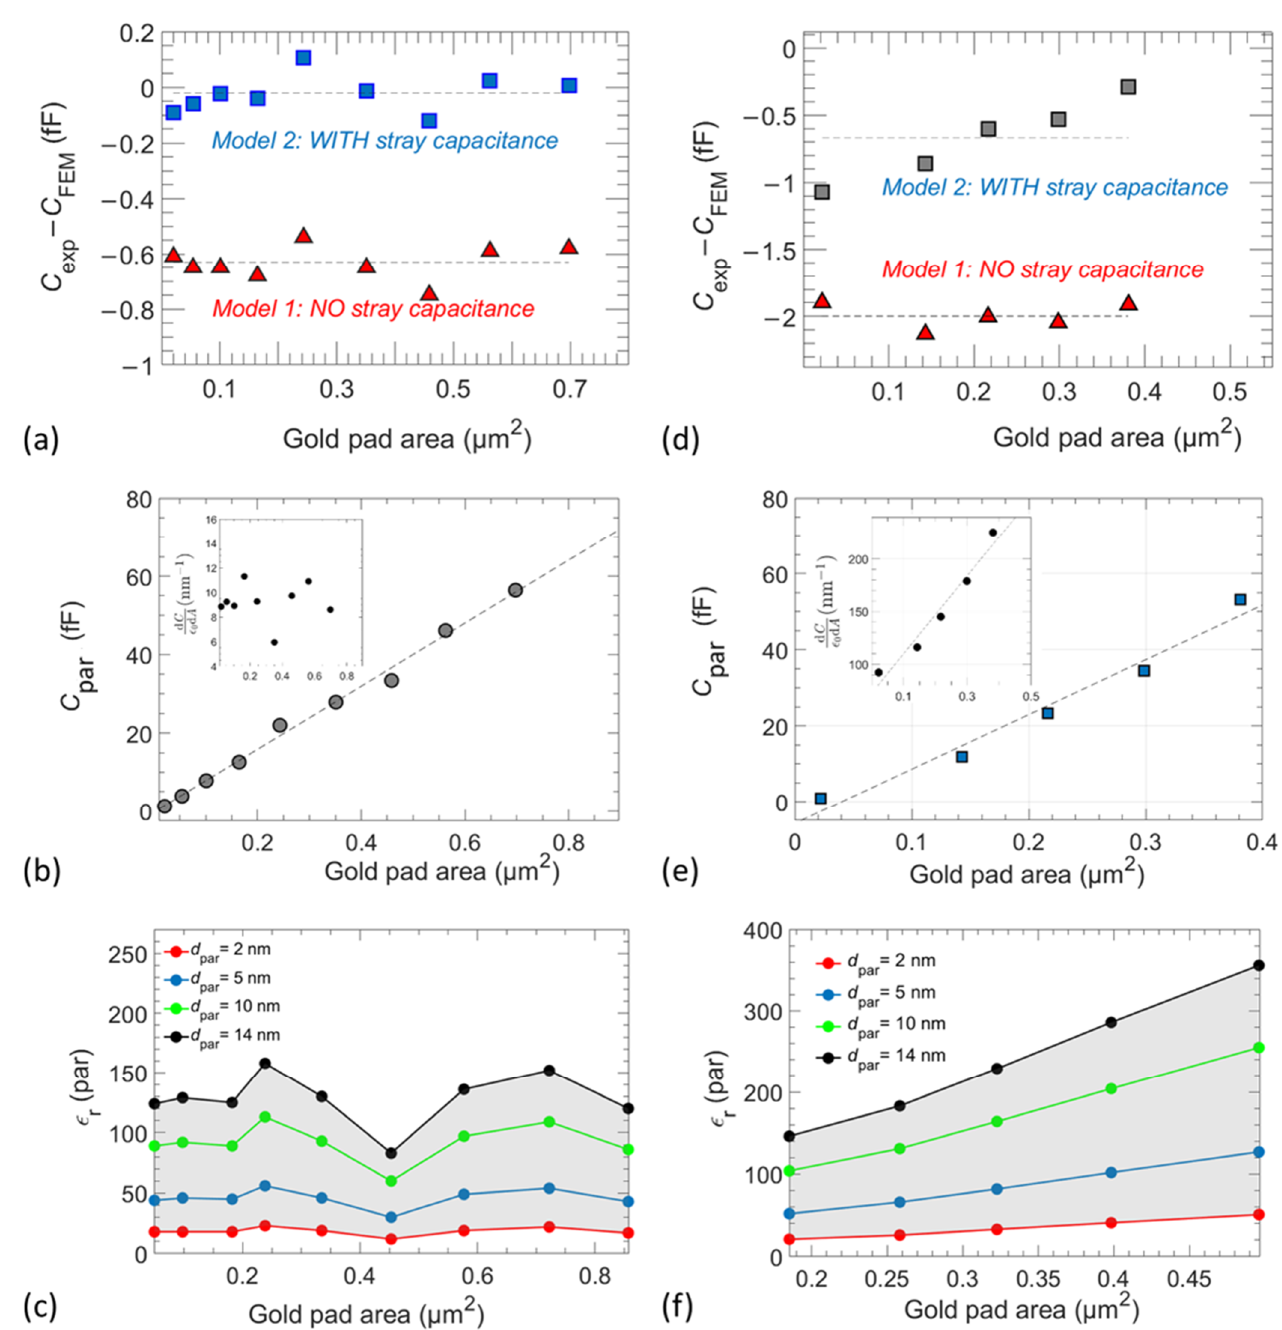
Figure 8. Study on PZT and PMN-PT sample at a frequency of 3.67 GHz; ( a , d ): Difference between C exp and C FEM as a function of the gold pad area on PZT (PMN-PT). ( b , e ): Parasitic capacitances with a thickness given the void volume at the PZT (PMN-PT) Surface; ( c , f ) corresponding dielectric constants of the parasitic capacitances. Insets in ( b , e ) show the derivative of the capacitance with respect to the gold pad area ε 0−1 d C /d A .